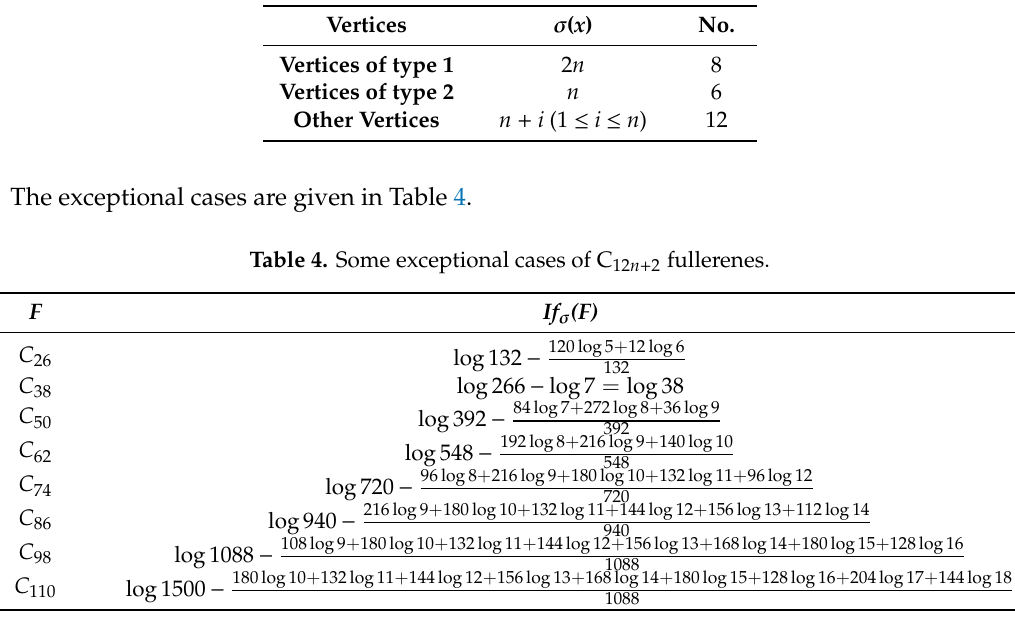
Table 3. The eccentricity of vertices of C 12 n + 2 , n ≥ 10.